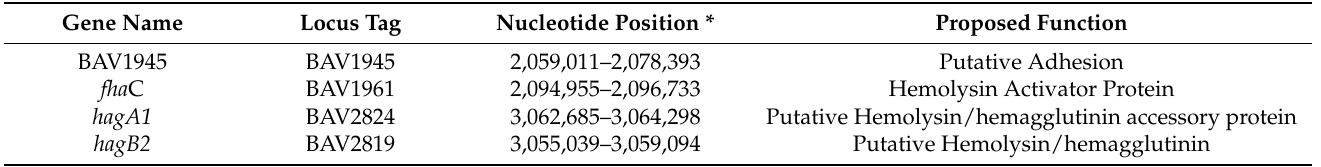
Table 1. Primary selected four Bordetella avium novel